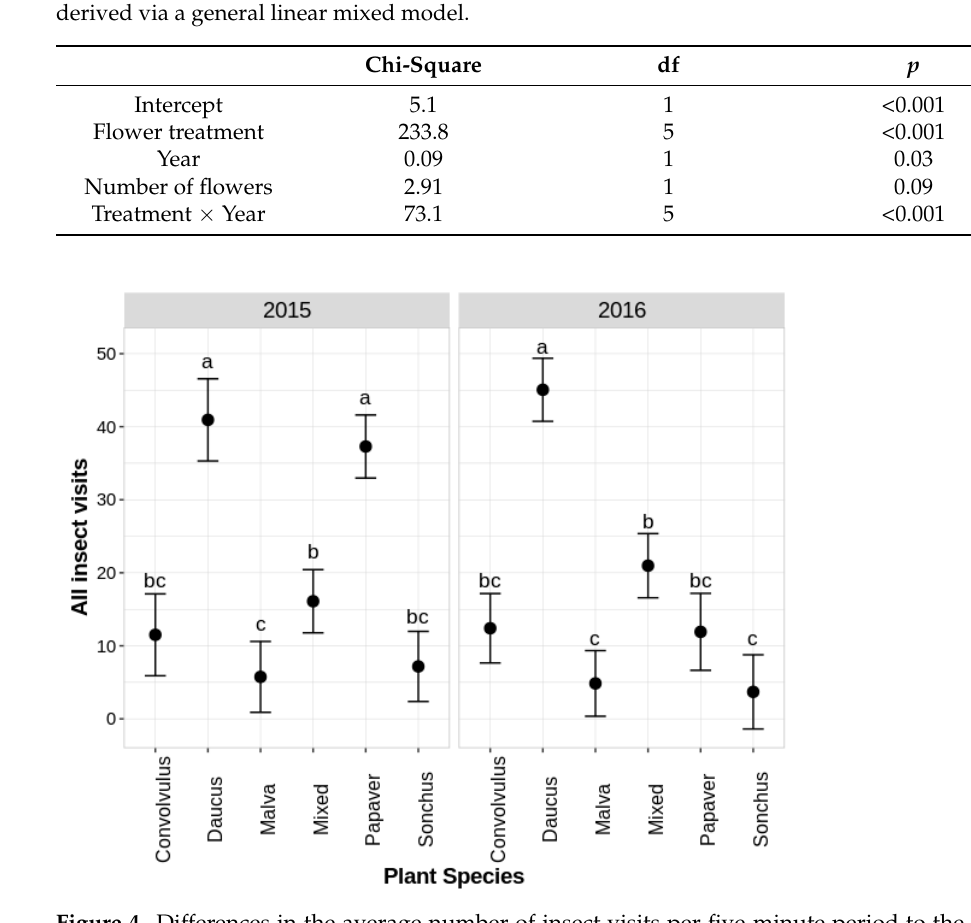
Figure 4. Differences in the average number of insect visits per five-minute period to the flower treatments in both years of the study (2015 and 2016). Values are the estimated marginal means from the general mixed-effects model accounting for the number of flowers in the plots. Bars show confidence intervals at the 0.95 level. Letters indicate differences between treatments derived from post hoc pairwise comparisons using the Tukey method for p -value adjustment (at p < 0.05). Contrasts were performed between treatments and for each year separately. Flower species are indicated by